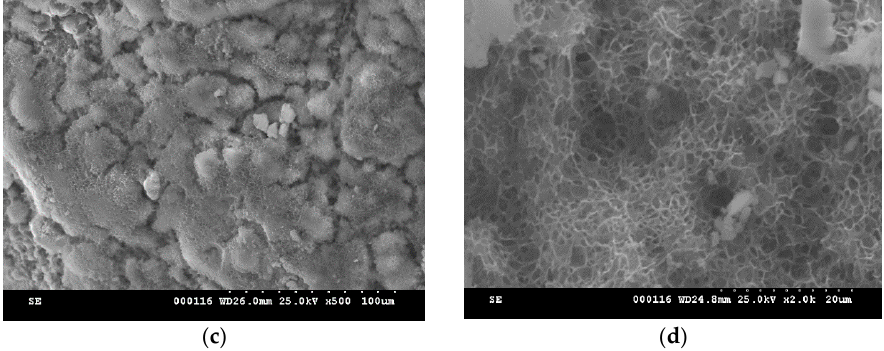
Figure 12. SEM micrographs of MTA pastes hydrated for 7 days and the immersed SBF for 14 days at 37 °C: ( a ), ( b )—MTA1; ( c ), ( d )—MTA2.